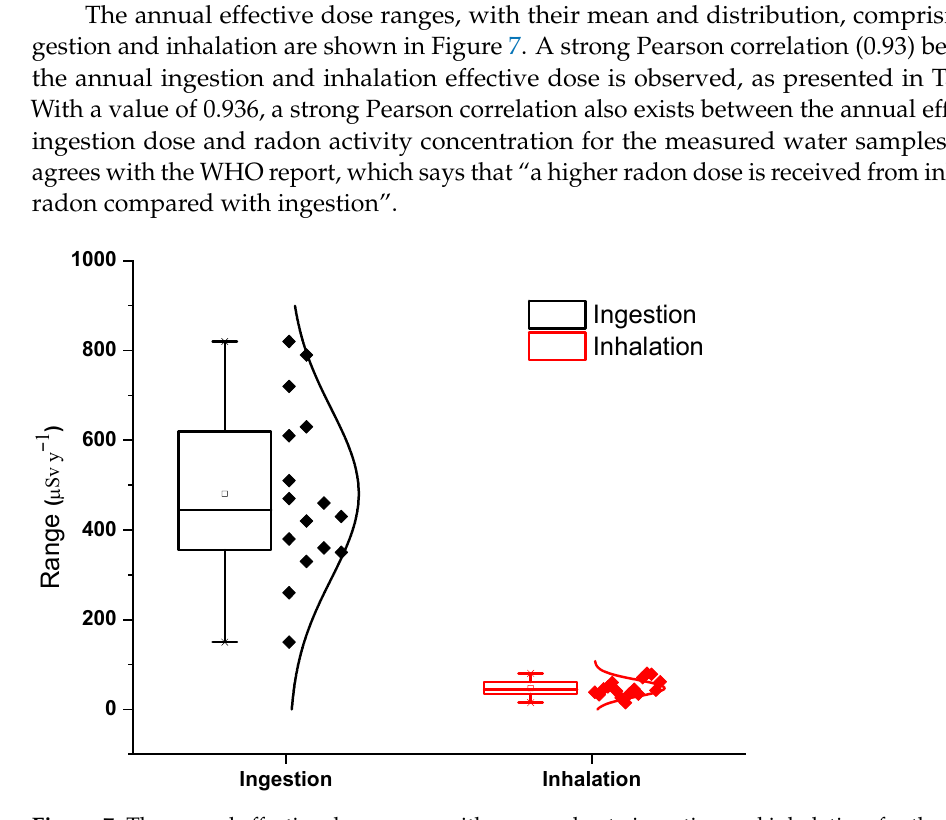
Figure 7. The annual effective dose range, with means, due to ingestion and inhalation, for the sixteen water samples. Table 1. Pearson correlations between ingestion and inhalation of the annual effective doses, with radon concentrations. Average Radon Conc. Ingestion Inhalation Pearson Corr. Pearson Corr. Pearson